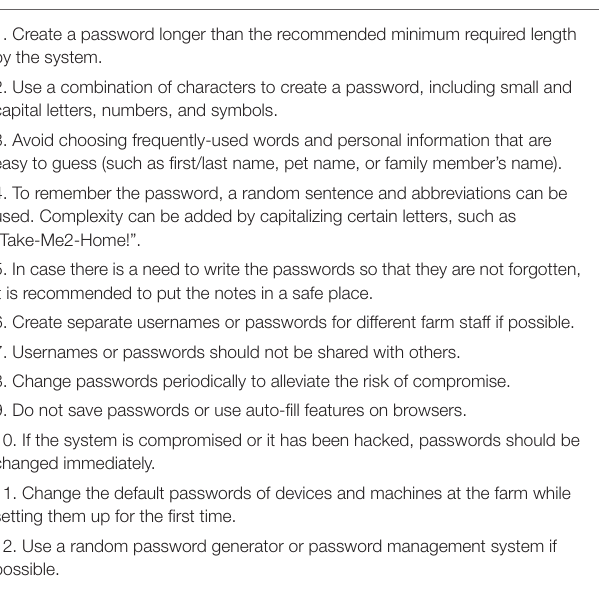
TABLE 1 | Guidelines for creating strong passwords. Guidelines to create and use strong passwords for